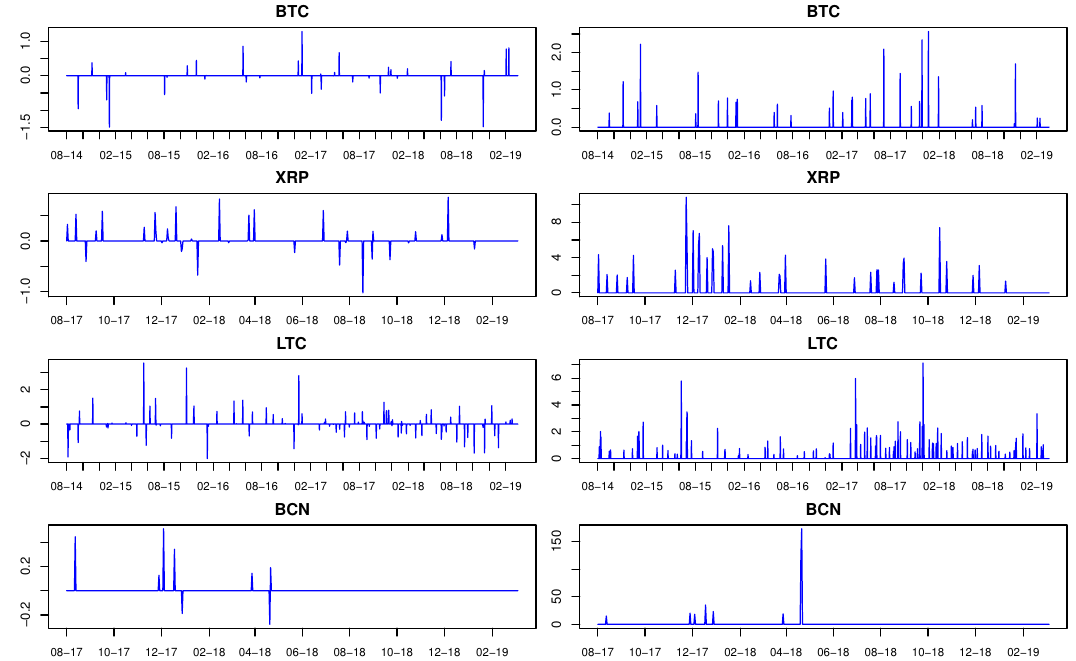
Figure 1. Jumps in returns ( left columns ) and jumps in volatilities ( right columns